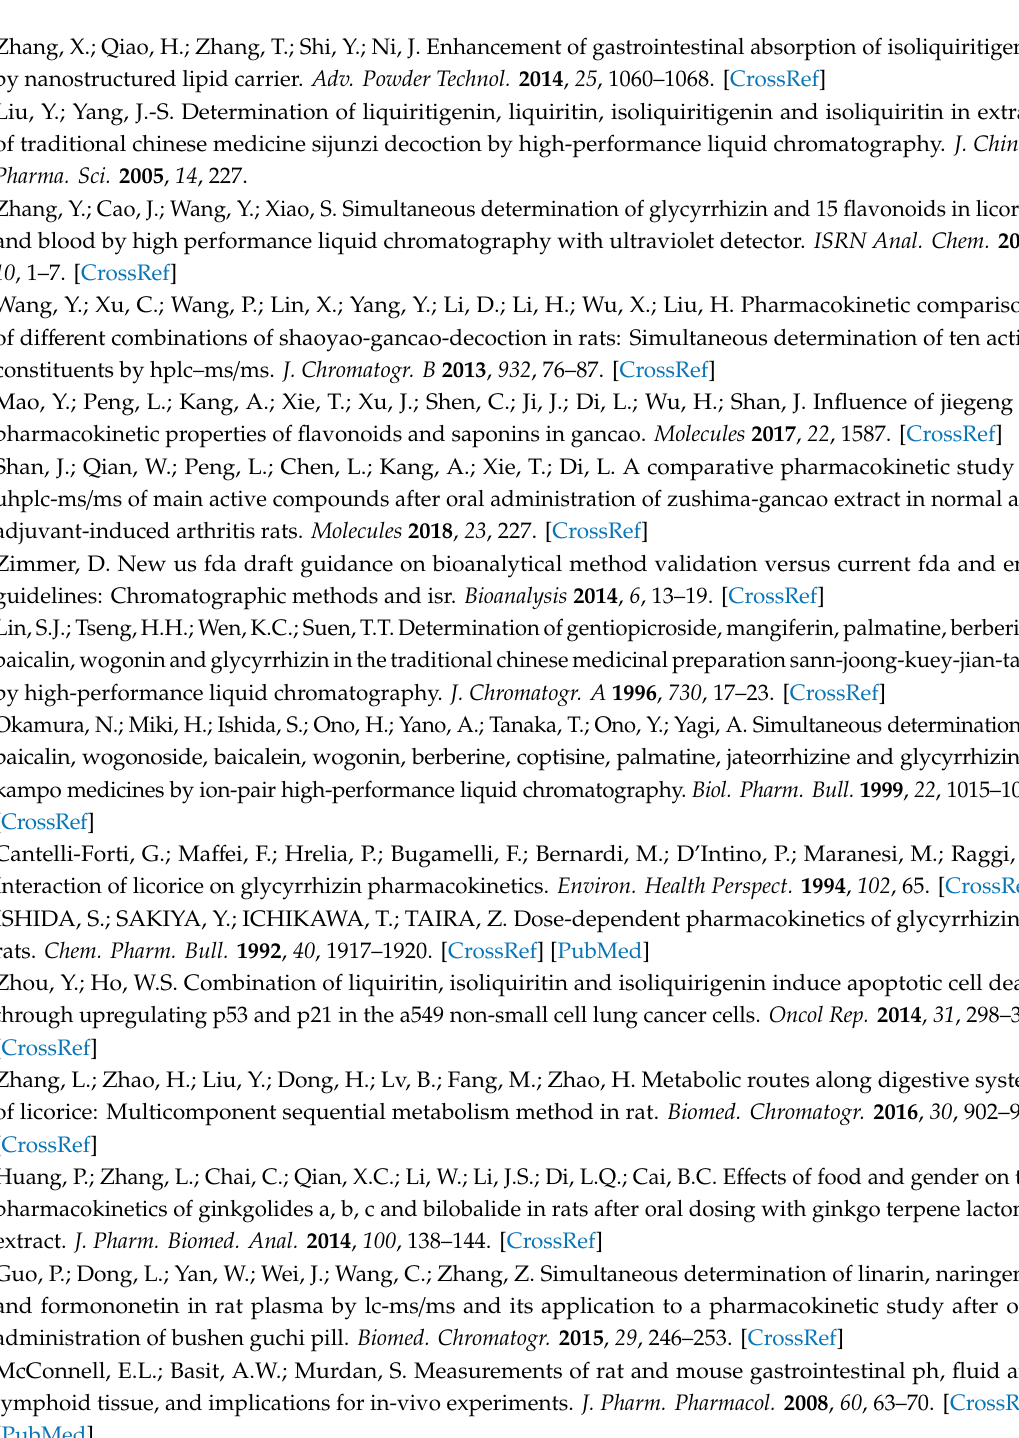
Sample Availability: Samples of Glycyrrhizae Radix extract (#KNUNPM GR-2015-001) are available from the